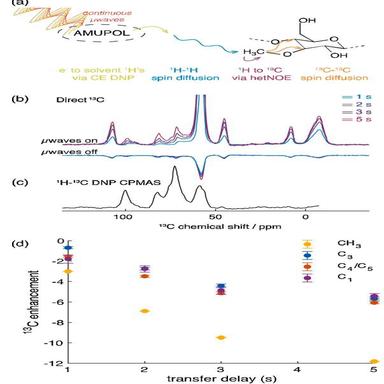
(a) Principle of substitution site identification for the reference sample 3-O-methylcellulose by combining DNP MAS with hNOE and 13C-13C spin diffusion. (b) Direct 13C NMR spectra with (plain line) and without (dashed line) μwave irradiation, and with recycle delays varying from 1 to 5 s and (c) 1 H-13C DNP CPMAS of 3-O-methylcellulose impregnated with 10 mM AMUPOL in D2O:H2O 9:1v/v at 5 kHz MAS, at ca. 100 K. (d) 13C enhancement (from direct 13C NMR) as function of the recycle delay and for the different